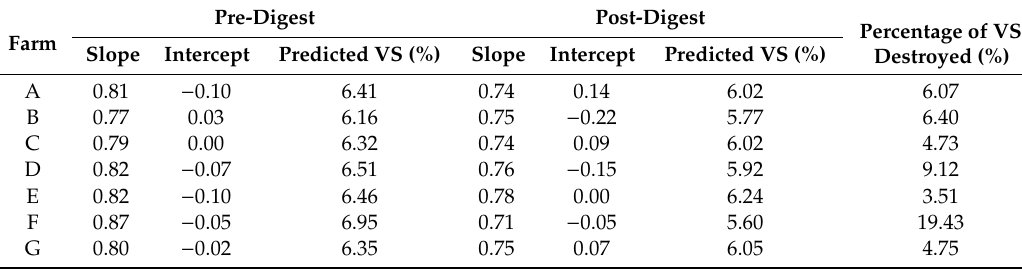
Table 3. Volatile solids content for pre-digested and post-digested manure and volatile solids destroyed.